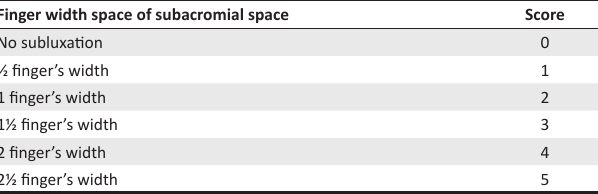
Source : Photo taken by N. Comley-White FIGURE 2: Circumferential